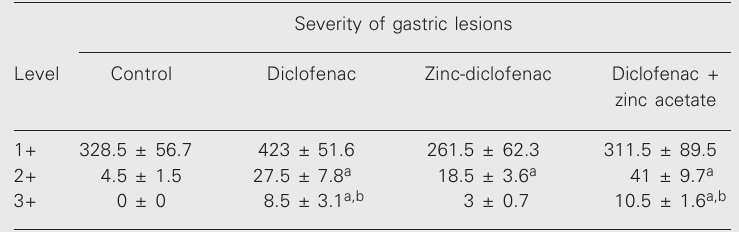
Table 4. Gastric lesions induced by a 7-day per os treatment.